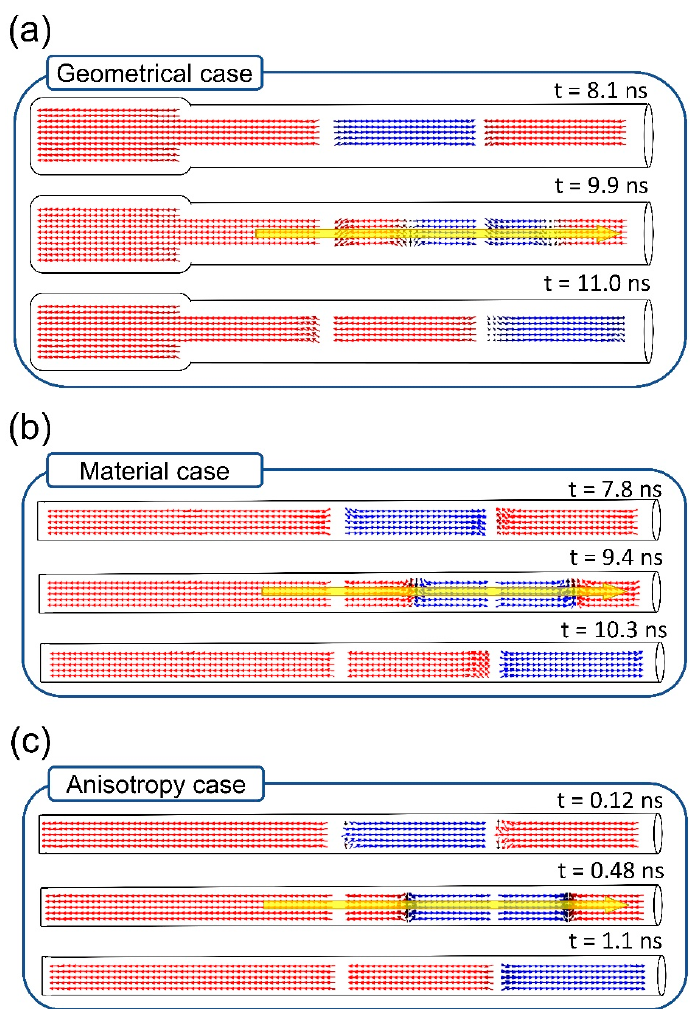
Figure 4. Representation of the ( a ) geometrical, ( b ) material and ( c ) anisotropy cases during the bit movement. The time necessary to depin the domain wall (top) and to complete the bit movement (bottom) is shown in each case. The time indicated in each case corresponds to the time elapsed since the current pulse started.